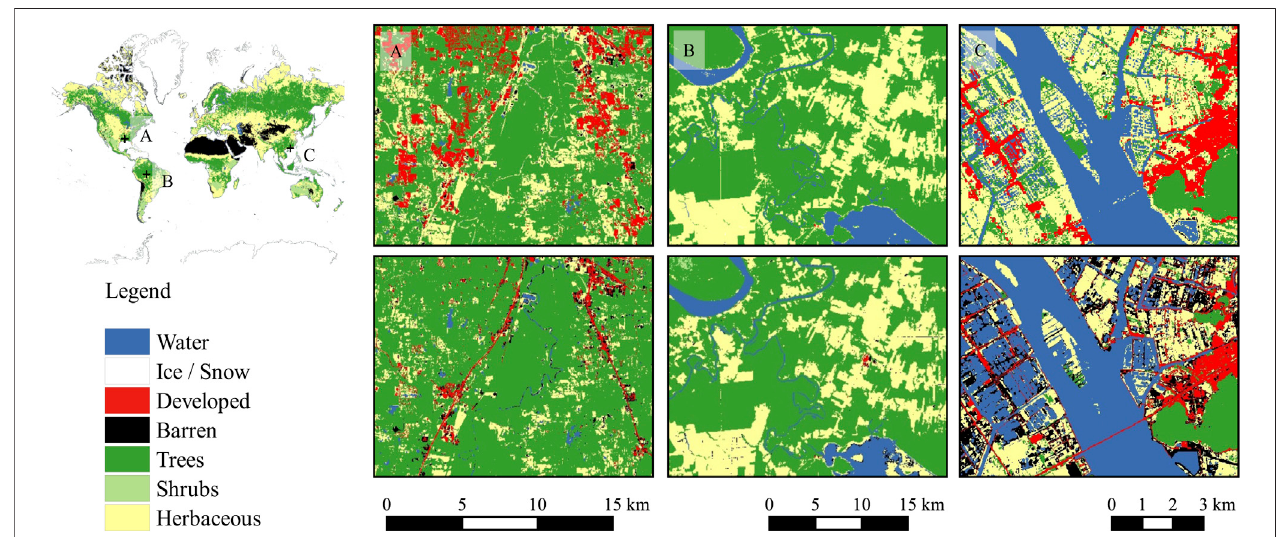
FIGURE 6 | Comparison of GLanCE maps (top row) with ESA WorldCover (bottom row) for locations: Louisiana (A) , Brazil (B) , and southern China (C) .